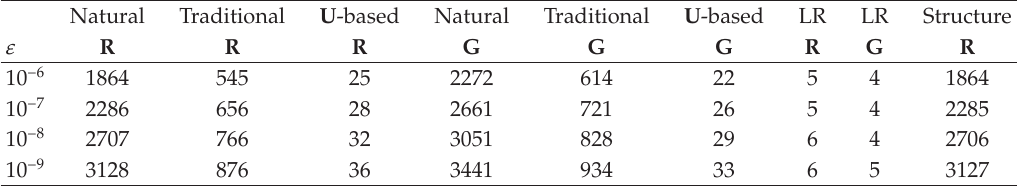
Table 5: Number of iterations required for di ff erent methods for interarrival times having